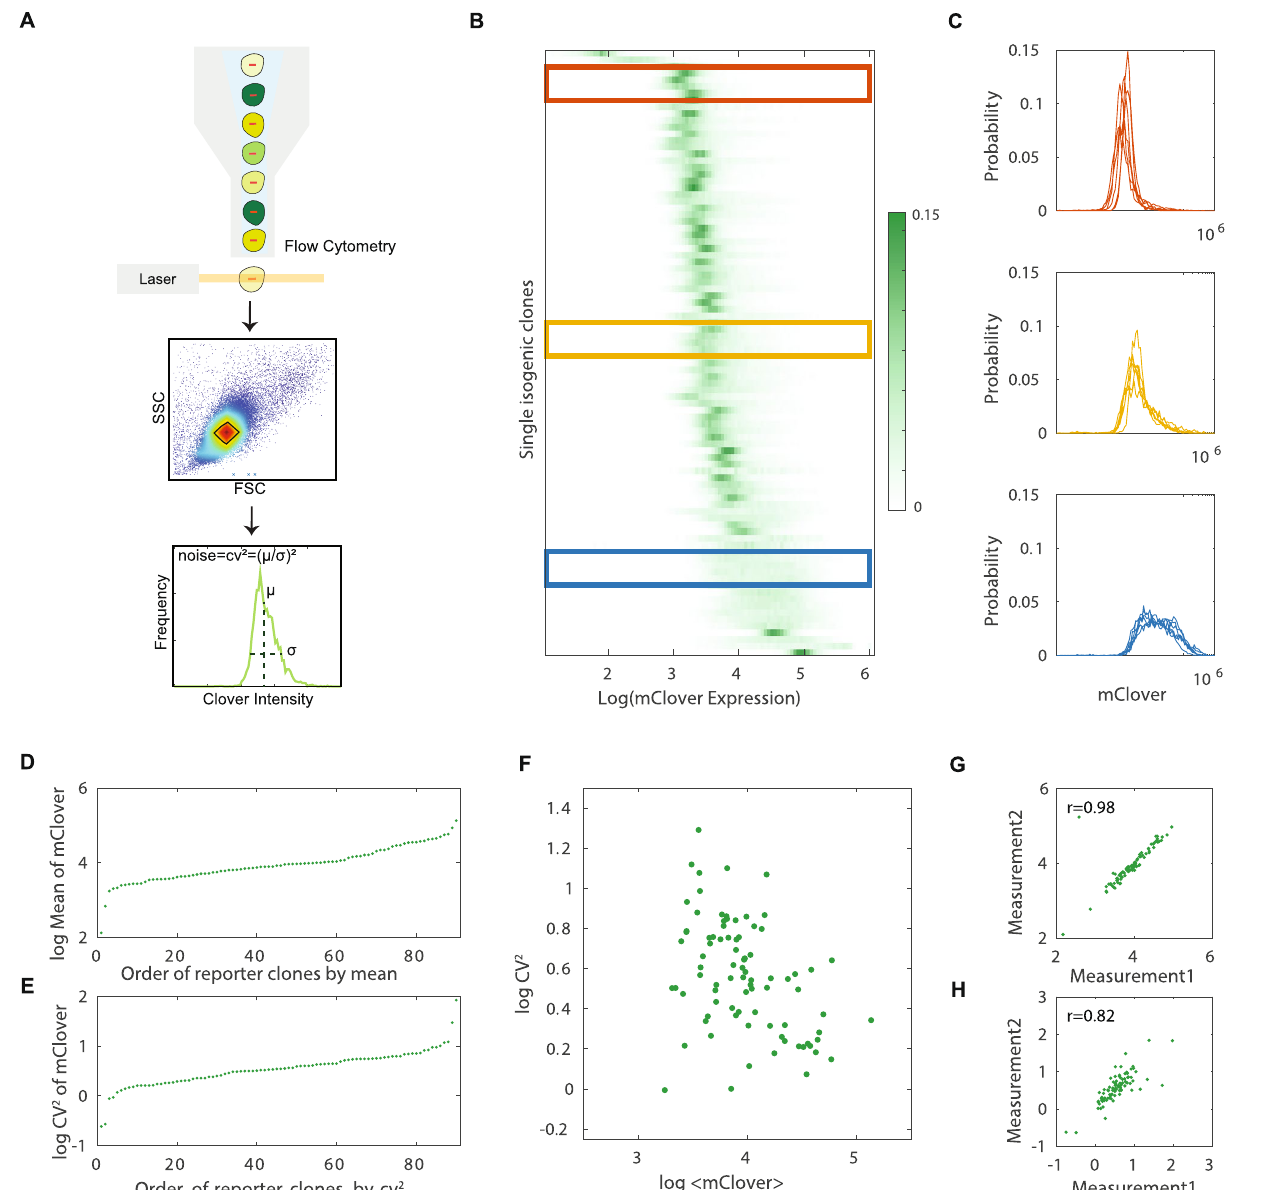
Figure 2. Gene expression distribution of a library of isogenic cell lines expressing CMV driven mClover fluorescent reporter shows dramatic gene expression variability. ( A ) Reporter expression at the single-cell level was measured by high-throughput flow cytometry for three replicates. A conservative gate controlling cell size, volume and cycle were applied to 50,000 live cells collected from each isogenic clone to minimize extrinsic noises. Gene expression variation can be quantified by CV 2 which is a measure of noise independent of gene expression levels. ( B ) Stacked probability density function of log10 expression of mClover in 90 cell lines. Each row in the heatmap represents a single histogram with the probability density function color coded. ( C ) Examples of the histogram of 30 cell lines from the top (red), middle (yellow), and bottom (green) of the stack in ( B ). ( D , E ) The mean ( D ) and noise ( E ) of Clover levels in 90 isogenic clones. Each point represents averaged fluorescence intensity ( D ) or the intrinsic noise CV 2 ( E ) of Clover of a single reporter clone representing the data from one specific genome location. ( F ) Scatter plot of the measured mean and noise across positions. For clarity extreme points shown in ( D ) and ( E ) are omitted. Axes are on a logarithmic scale. ( G – H ) The mean ( G ) and noise ( H ) of Clover expression of each isogenic clone is plotted for two measurement replicates (Spearman’s rank-order correlation coefficient is 0.98 for expression mean ( G ) and 0.82 for expression noise ( H ); both axes are in logarithmic scale). Each measurement was performed independently on different experimental setup and